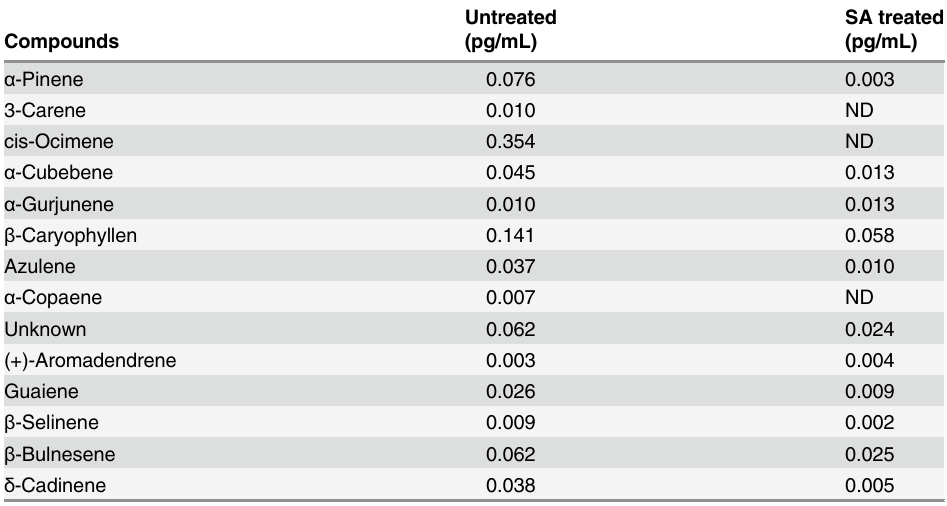
Table 1. GCMS analysis of volatile compounds from untreated and SA treated mango fruit (Cv. Tota- puri). The concentration of volatile compounds equivalent to Dodecanal used as standard